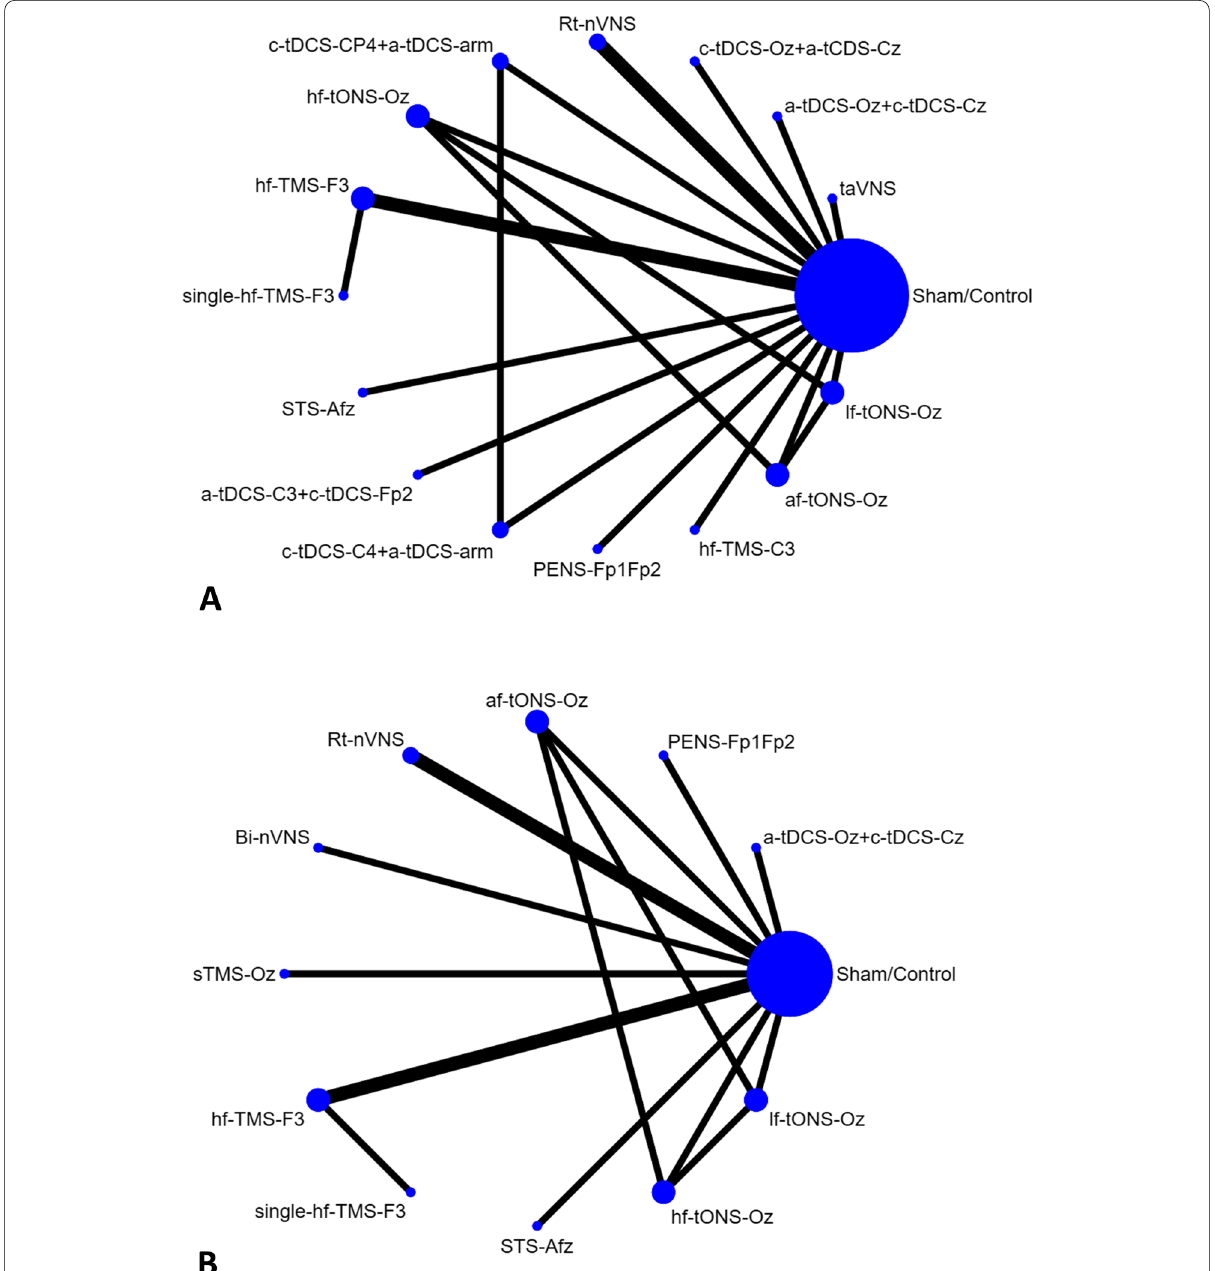
Fig. 2 Network structure of primary outcome: ( A ) changes in monthly migraine days and ( B ) response rate. AB Overall network structure of the current network meta‑analysis for the primary outcome of response rate. The lines between nodes represent direct comparisons in various trials, and the size of each circle is proportional to the number of participants receiving each specific treatment. The thickness of the lines is proportional to the number of trials connected to the